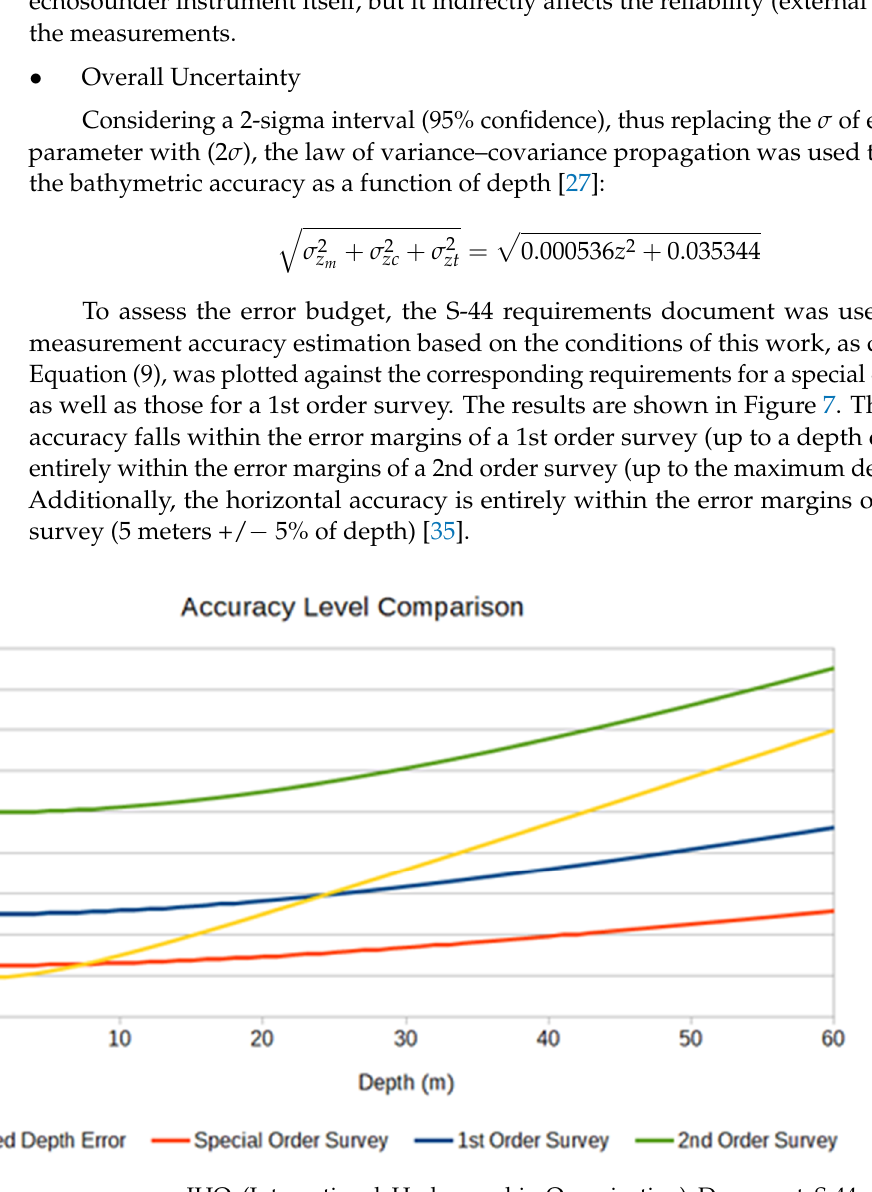
Figure 7. Overall survey accuracy vs. IHO (International Hydrographic Organization) Document S-44 accuracy requirements plot.